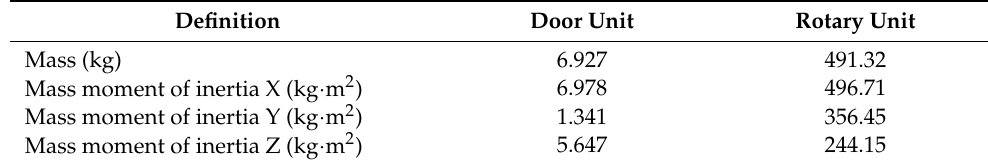
Table 2. Point Mass.